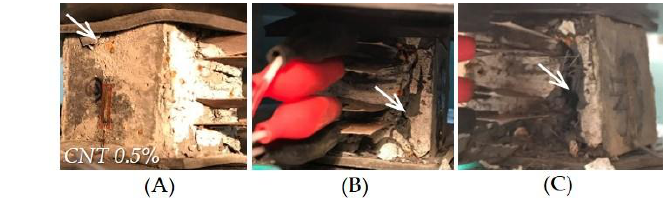
Figure 10. Process of fracture for UHPFRC with CNTs under compression: Small letter ( a ), ( b ) and ( c ) are CNT 0.1%, CNT 0.3% and CNT 0.5%, respectively. Capital letter ( A ), ( B ) and ( C ) indicate damage process of each specimen.